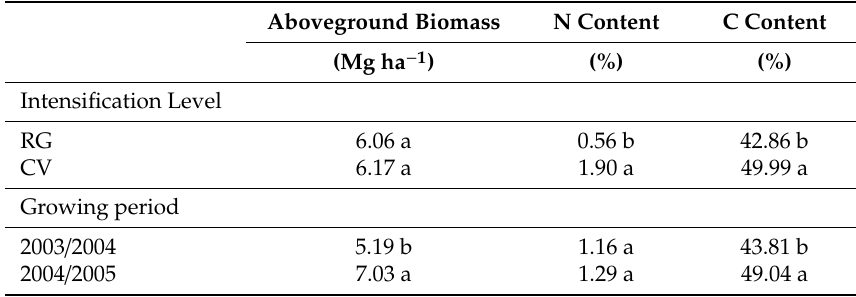
Figure 1. Rainfall and mean air temperature during the cover crop and pepper growing seasons in the two growing periods (2003 / 2004 and 2004 / 2005) with respect to average values overthe last 30-year period. Table 2. The main e ff ects of cover crops and growing period on the aboveground biomass and relative content of nitrogen (N) and carbon (C). Values belonging to the same variable followed by the same letter are not statistically di ff erent, according to LSD (0.05).